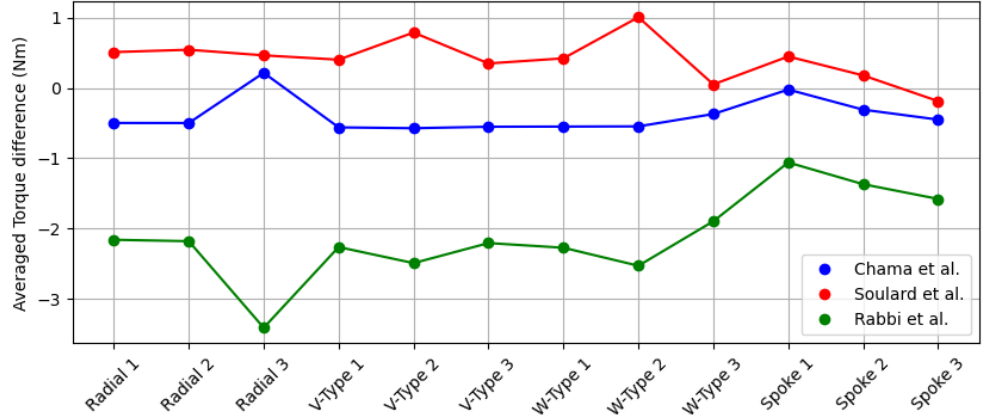
Figure 9. Average torque difference of various (Rabbi et al. [8], Chama et al. [9], Soulard et al. [19]) analytical T c s from target T c for each motor